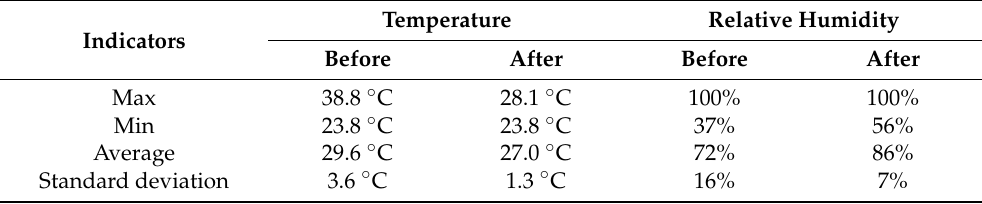
Table 6. Results of greenhouse environmental control on internal temperature and relative humidity before and after spraying for environmental cooling by the traditional spraying system (20 May 2019–20 July 2019). Temperature Relative Humidity Indicators Before After Before After Max